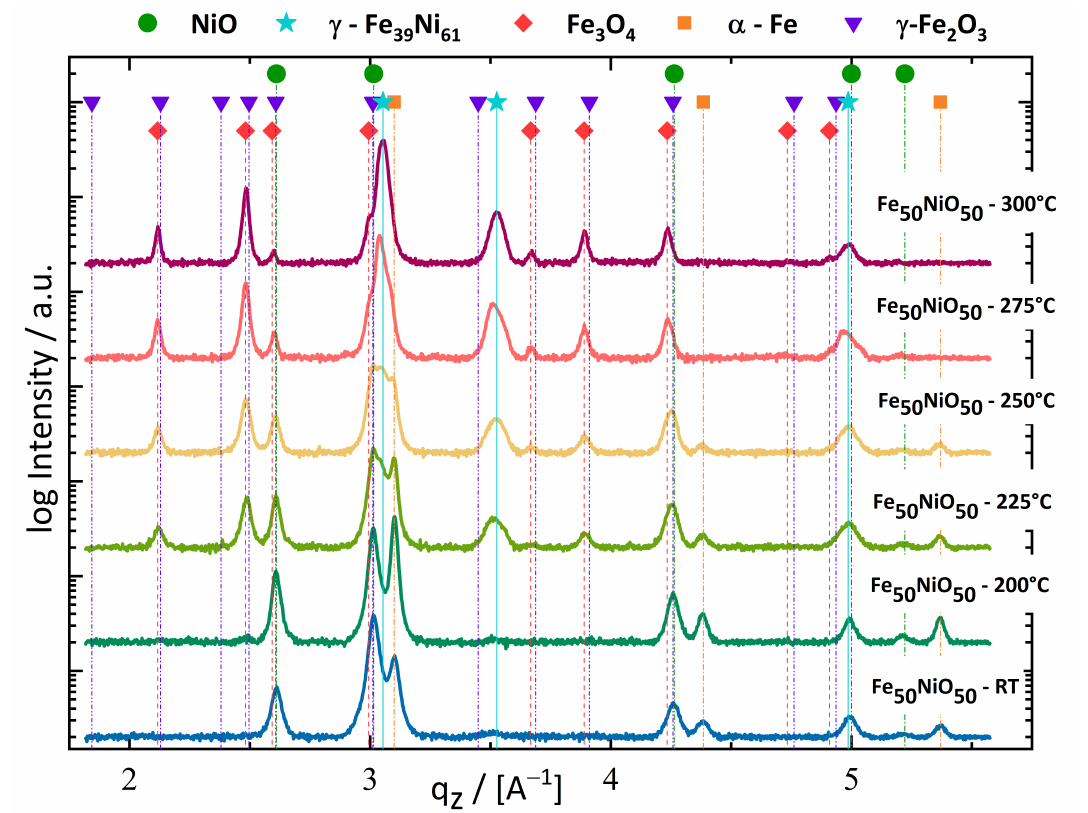
Figure 2. XRD-data is displayed of the Fe 50 NiO 50 sample, which was measured with laboratory equipment. The formation of Fe 3 O 4 , through the reduction of NiO by Fe, was seen for samples deformed at T def ≥ 225 °C. α -Fe was not detectable at T def ≥ 275